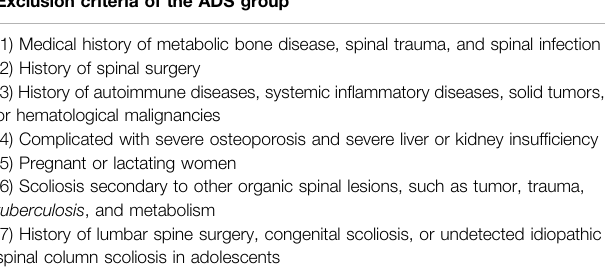
TABLE 2 | Exclusion criteria of the ADS group. Exclusion criteria of the ADS group